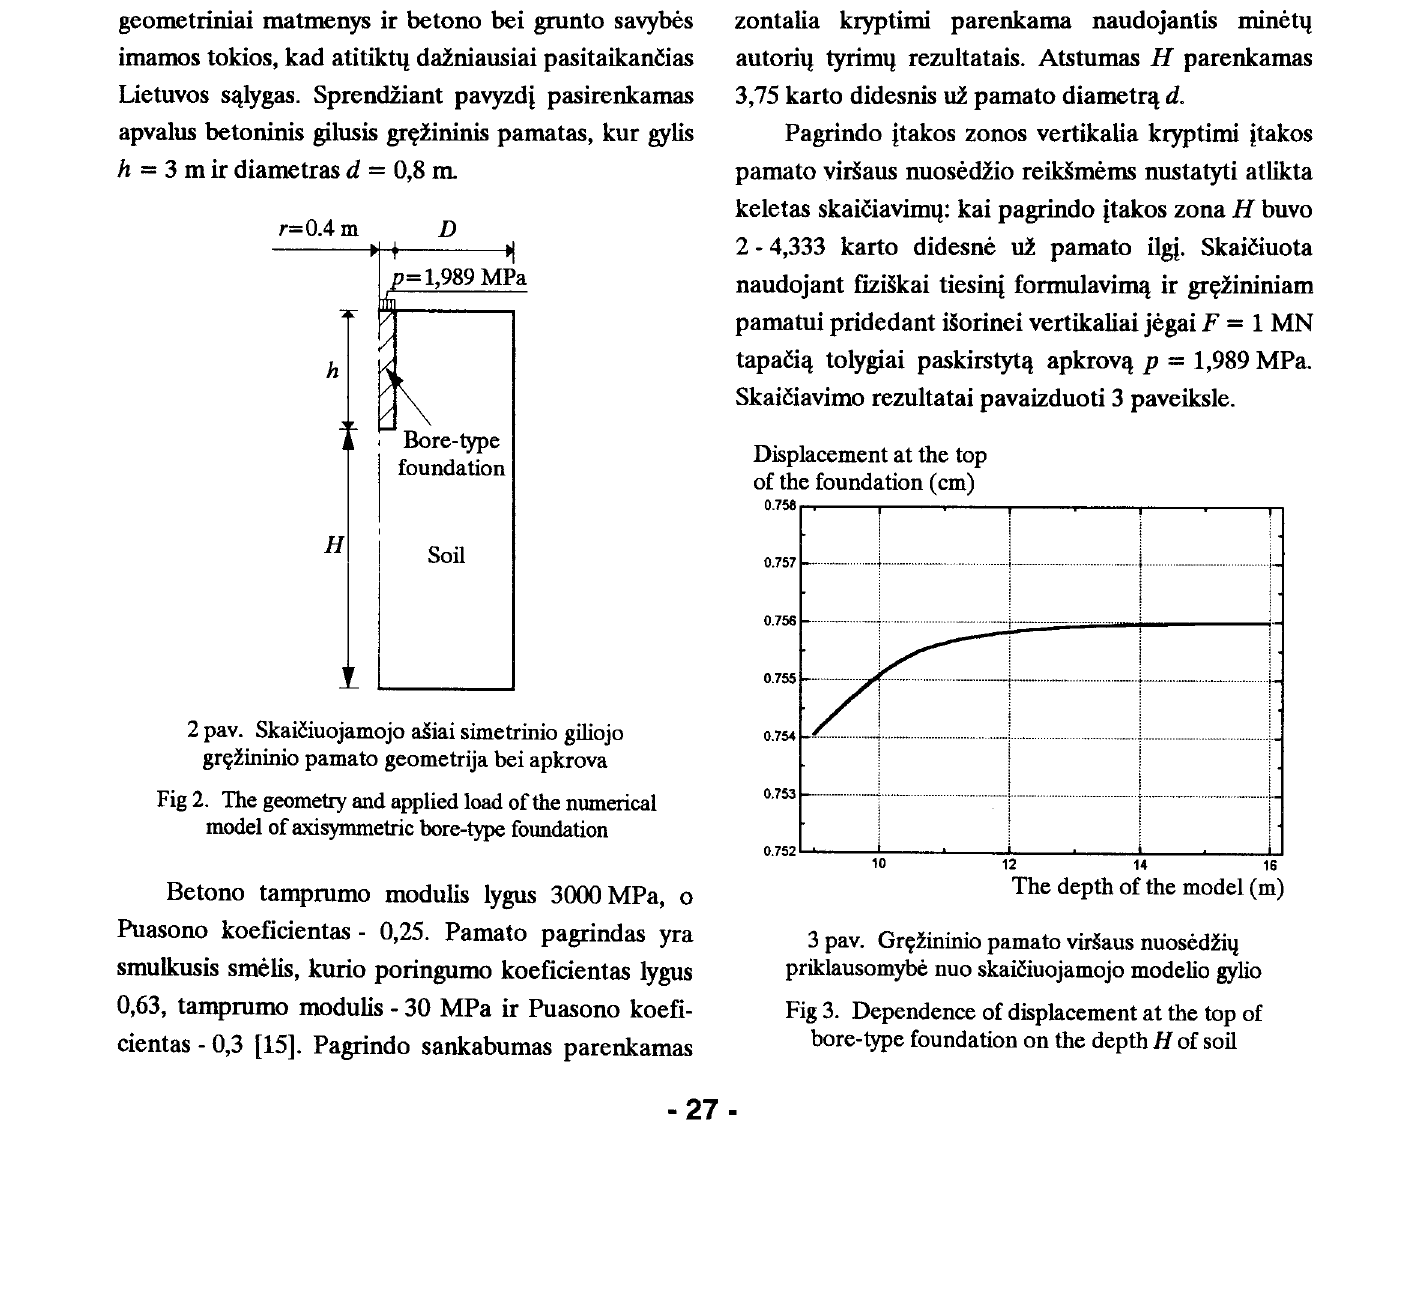
Fig 3. Dependence of displacement at the top of bore-type foundation on the depth H of